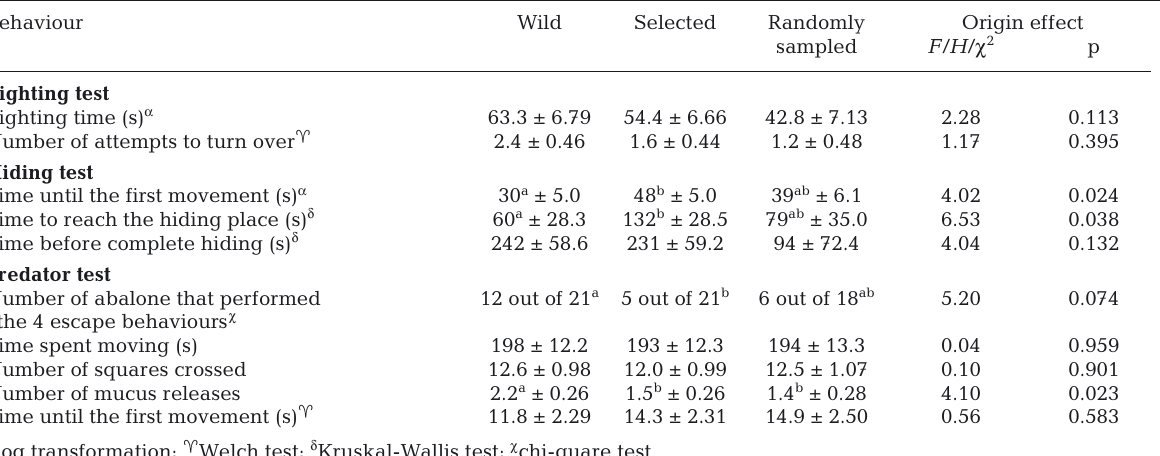
Table 2. Responses during behavioural tests of abalone Haliotis tuberculata offspring from 3 different broodstock origins (wild, farmed selected on weight and farmed randomly sampled); n = 19 abalone minimum treatment −1 , mixed model unless other- wise stated. Results are least square means ± SE. Values with different superscripts are significantly different (p <